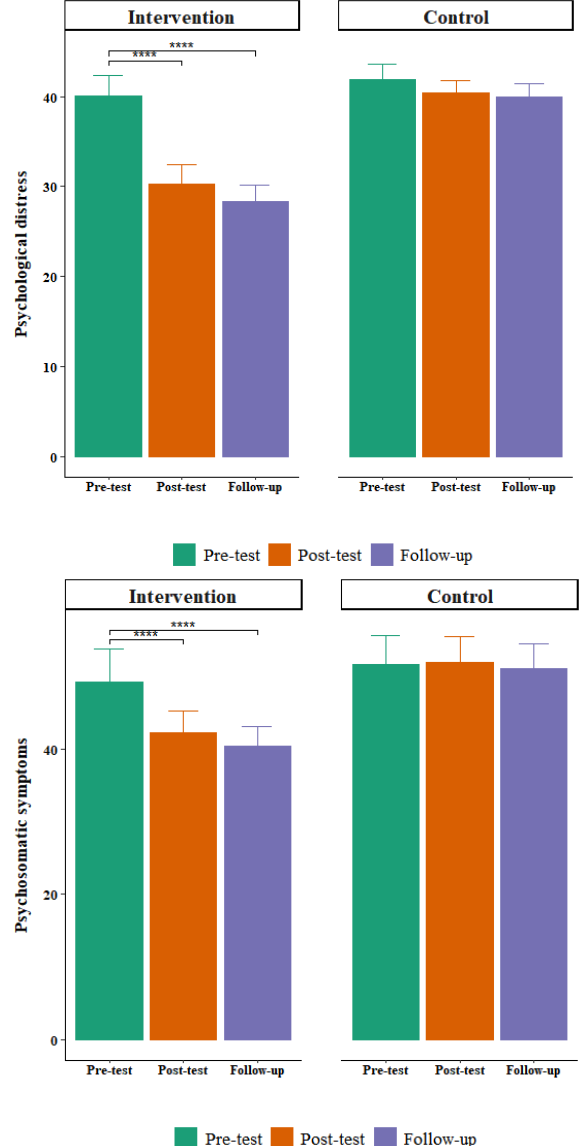
Figure 2. The multiple comparison of psychological distress and psychosomatic symptoms between time points (pre-test, post-test, and follow-up) using Bonferroni